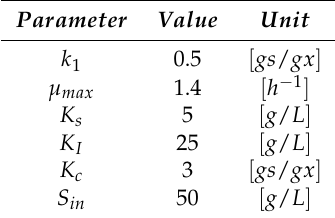
Table 1. Parameter values of model (3) considering Monod, Haldane or Contois kinetic laws.